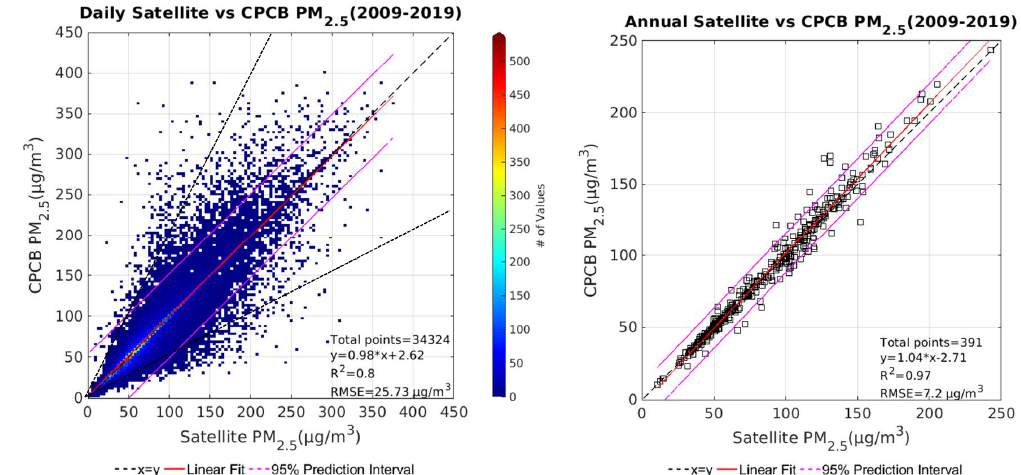
Figure 3. Regression statistics of ( left ) daily and ( right ) annual satellite-based and ground-based PM 2.5 concentration over India. The points falling outside the 1:2 and 2:1 line (shown as dotted lines) are considered as the outliers ( < 0.5% for the daily PM 2.5 product).